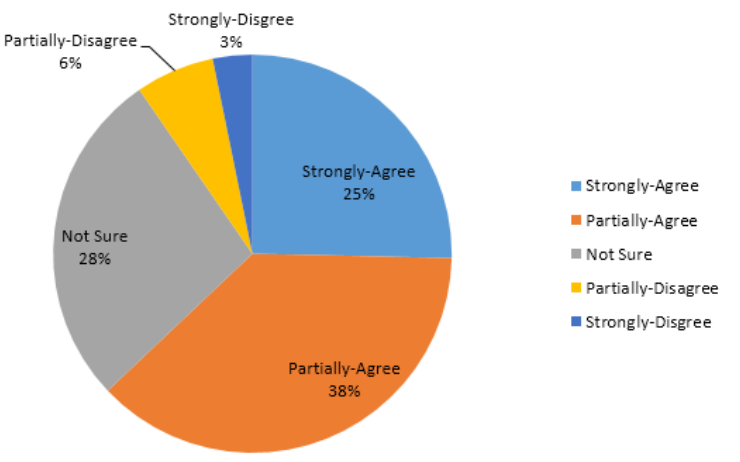
Fig. 2. IoT awareness indicator among experiment